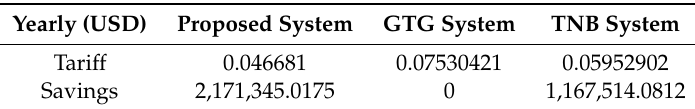
Figure 8. Energy production, (a) energy produced by PV array (b) energy produced GTG; (c) Battery charging and discharging energy;